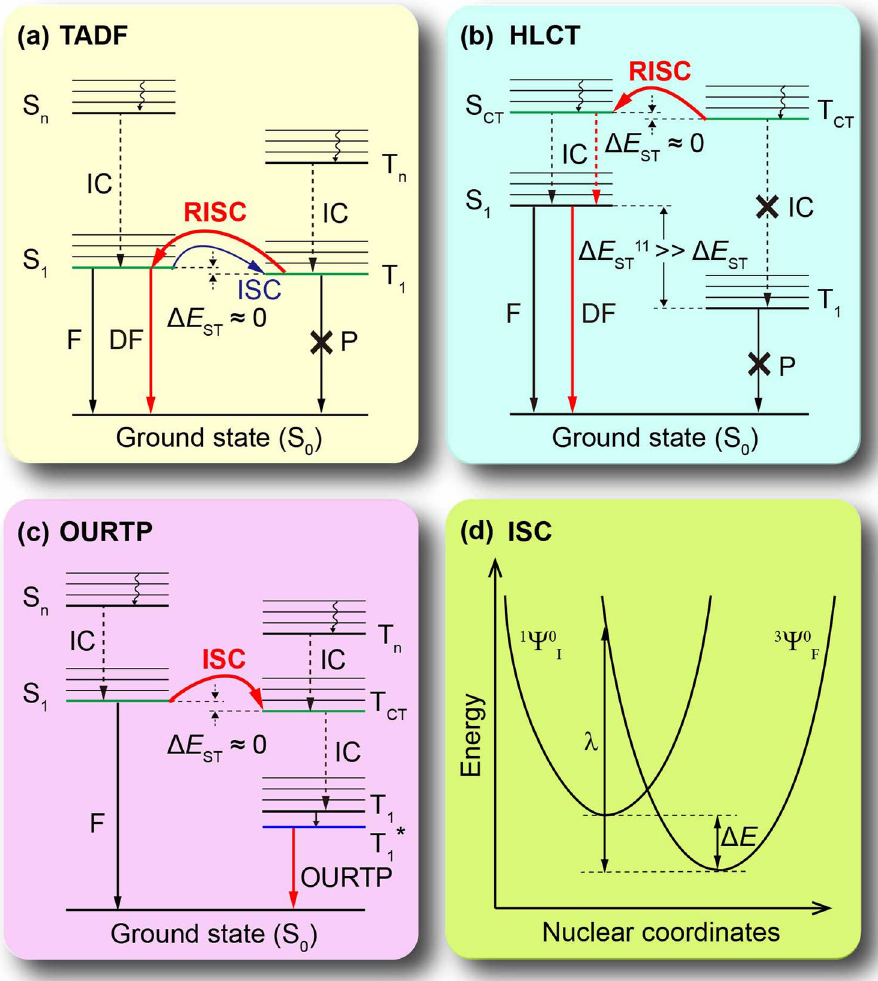
Figure 1. Energy level diagrams depicting diversified excited states transfer for exciton transformation in ( a ) TADF, ( b ) HLCT and ( c ) OURTP molecules and ( d ) harmonic energy surfaces representing ISC process. Noted that F, DF, P, IC represent fluorescence, delayed fluorescence, phosphorescence and internal conversion, respectively; Δ E ST is the energy splitting between the singlet states and triplet states, while Δ E ST11 is the energy splitting between the lowest singlet (S 1 ) and triplet (T 1 ) excited